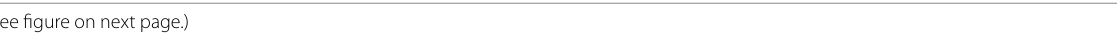
40 mm). e Variation = V GS 4 V. f Gate dielectric leakage current Vs = =